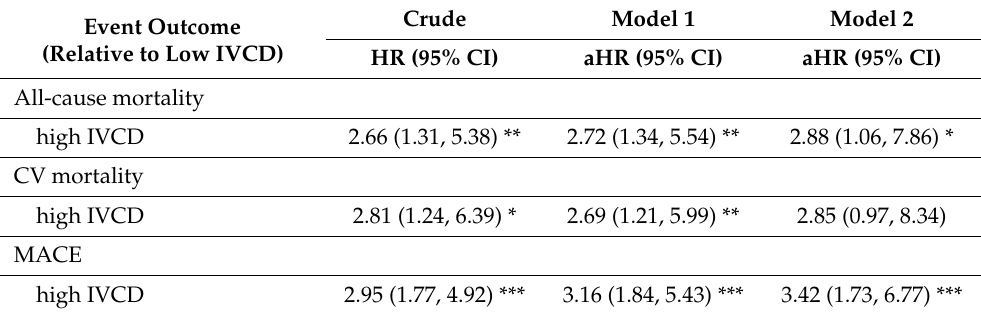
Table 4. Cox regression analysis for inferior vena cava diameter (IVCD) with mortality, CV mortality, and MACE. MACE, major adverse cardiovascular events.